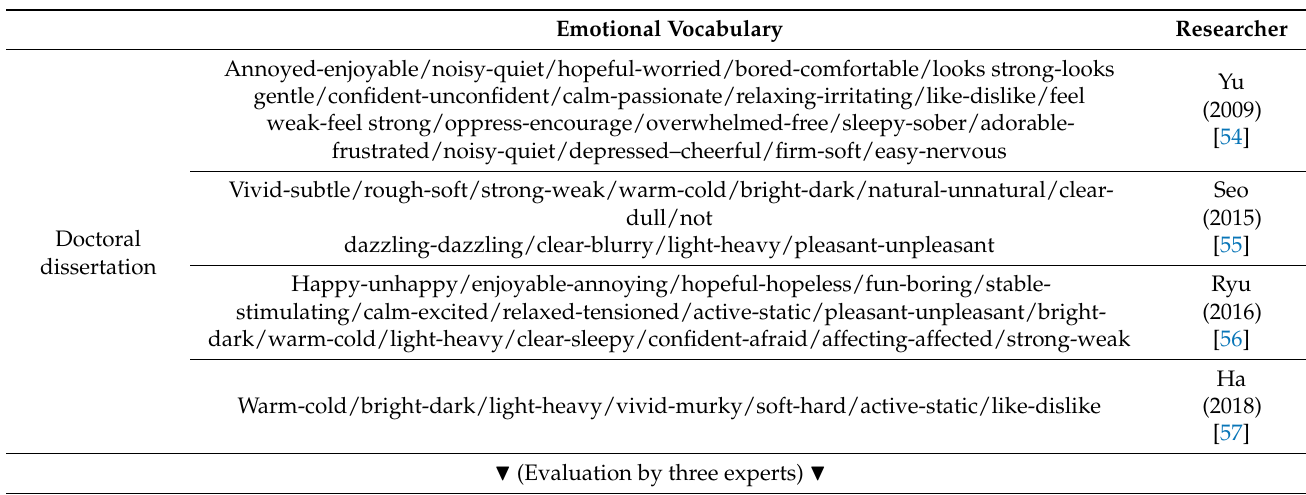
Table 4. Stress assessment vocabulary selection